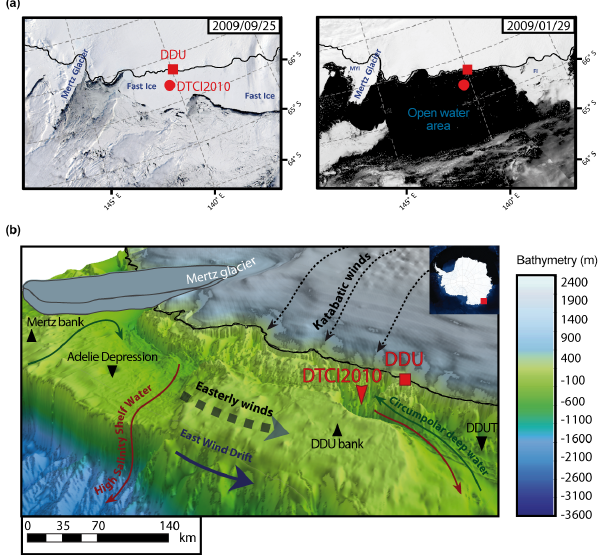
Figure 1. Study area. (a) Modis satellite images of Adélie Land, showing mean sea ice conditions from early spring to summer in the region, the location of sediment core DTCI2010 and the French research station Dumont D’Urville (DDU). (b) Map of the study area showing the location of sediment core DTCI2010 in the Du- mont D’Urville Trough (DDUT), the main glacial and topographic features, the principal water masses (solid lines) and the main wind streams (dashed